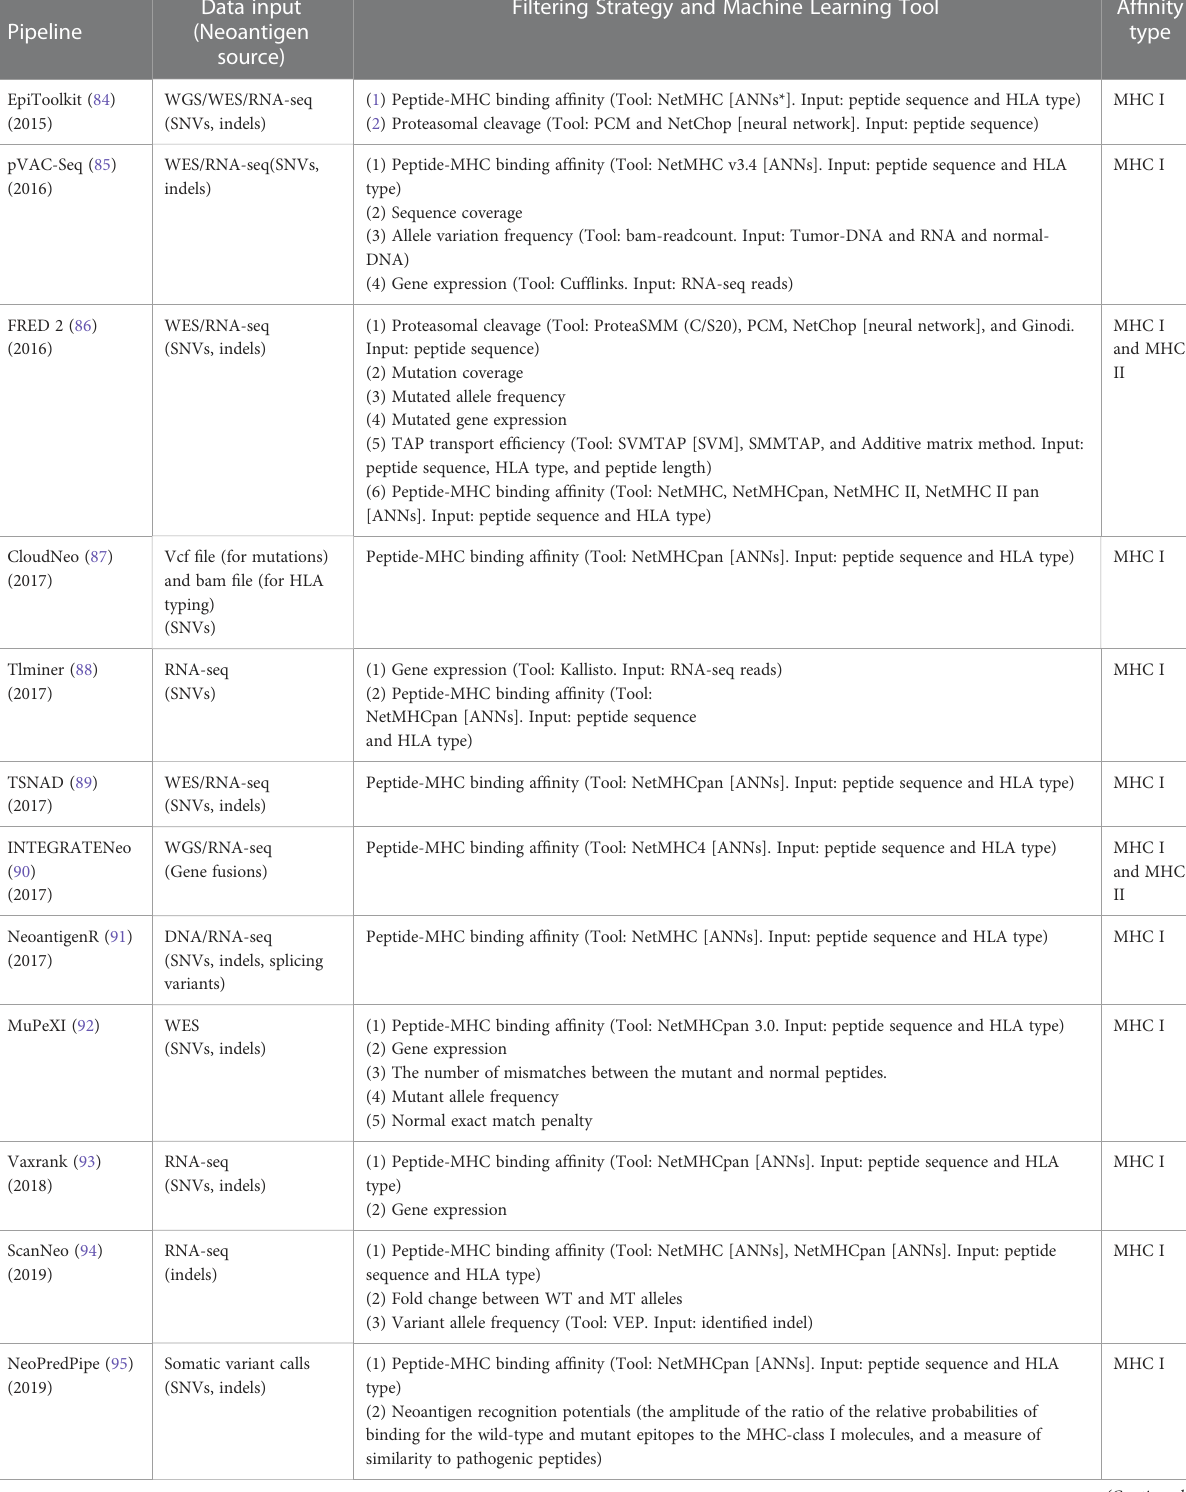
TABLE 1 Neoantigen prediction pipelines extracting peptide-HLA binding af fi nity as key